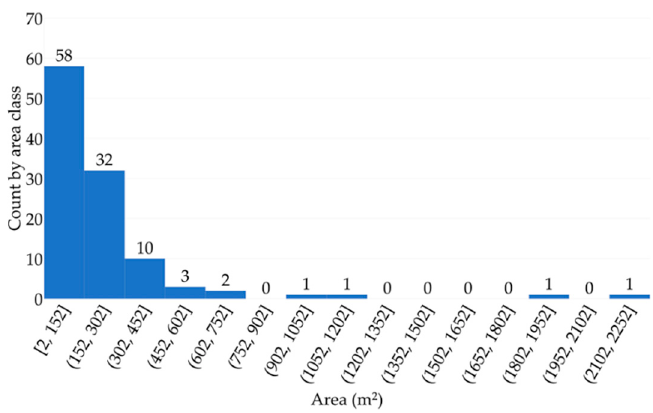
Figure 9. Thermokarst lake and pond size distribution in the KWAK study area.